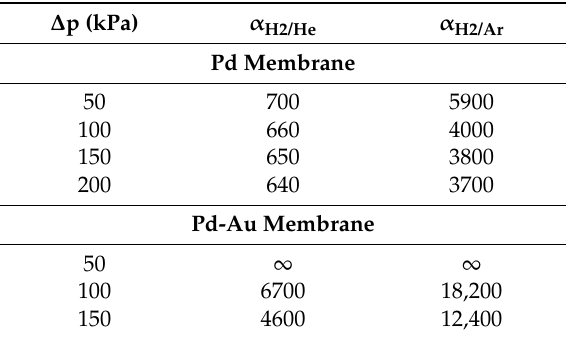
Table 3. Ideal Selectivity of H 2 with respect to He and Ar under various pressures at 400 ◦ C for composite Pd and Pd-Au membranes. ∆ p (kPa) α α H2/He